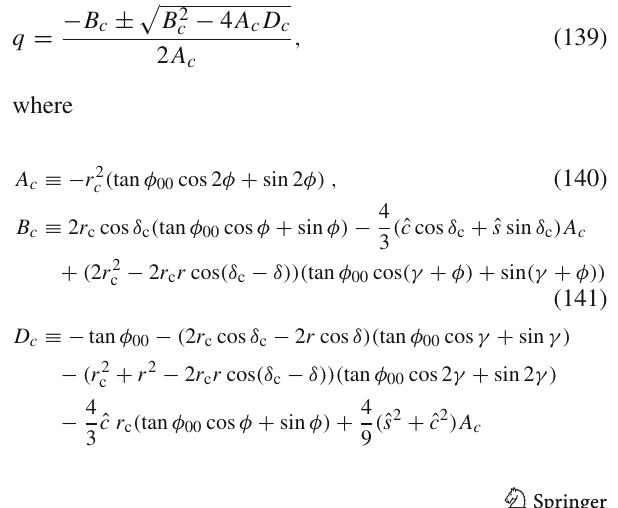
Fig. 12 Error budget for the isospin contour in the φ – q plane that is consistent with the R c constraint in Eq. (135): a impact of the various parameters when varying them individually within their 1 σ ranges; b